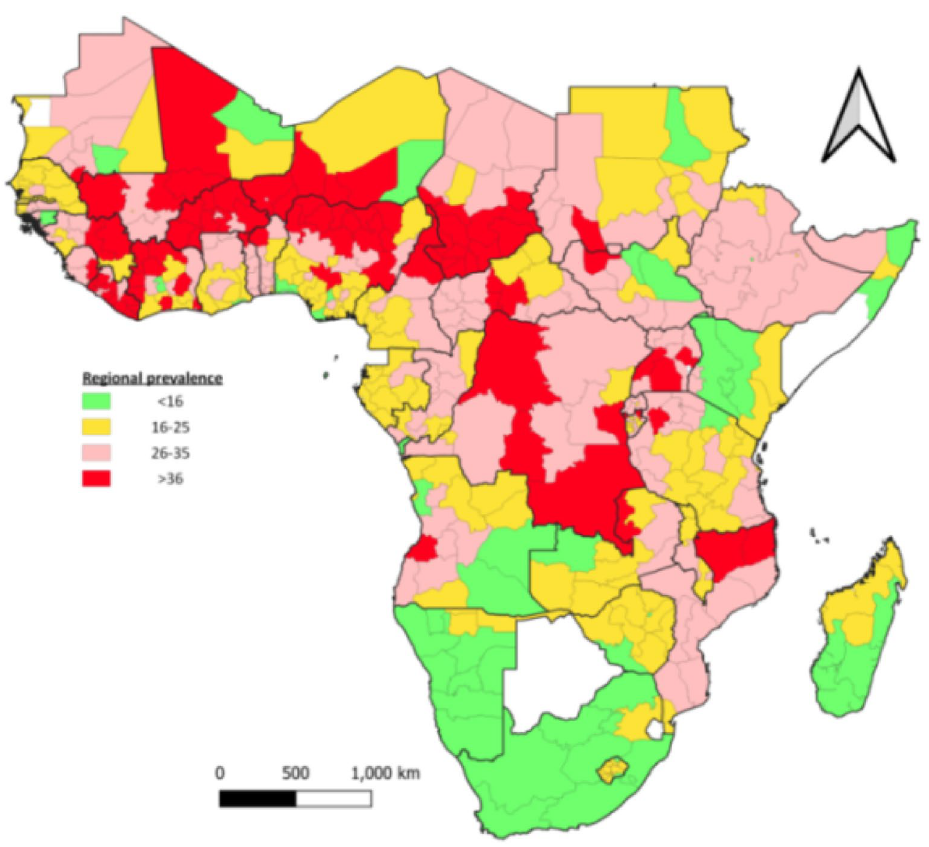
Figure 4. Subnational prevalence of mothers who lost at least one child due to death: the color from green to red shows an increasing prevalence of women who have lost at least one child. This analysis was carried out by QGIS 3.16.